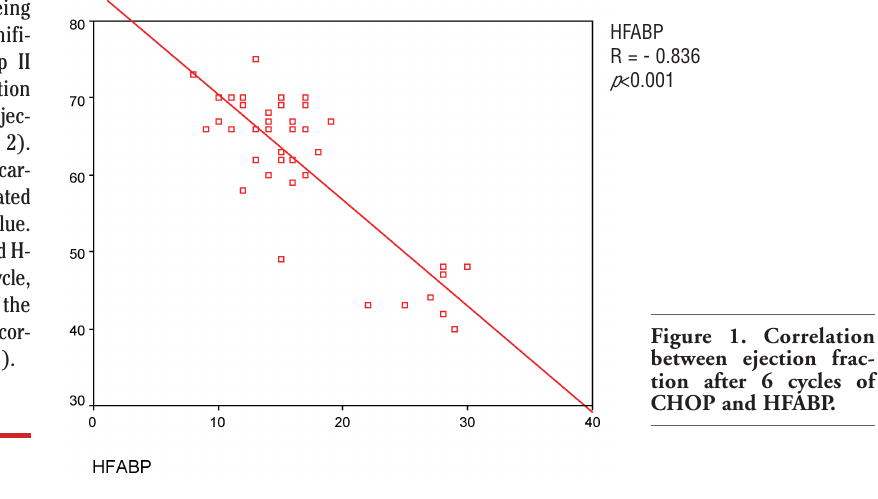
HFABP R = - 0.836 p <0.001